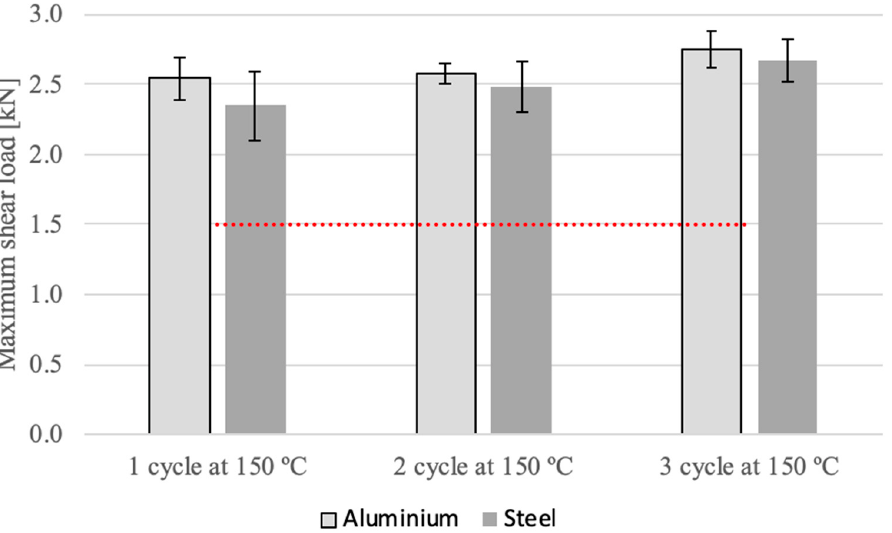
Figure 19. Maximum shear strength of RJS specimens subjected to multiple repair cycles. The red dotted line represents the threshold value for the RJS specimen’s minimum allowed joint strength (1.5 kN).